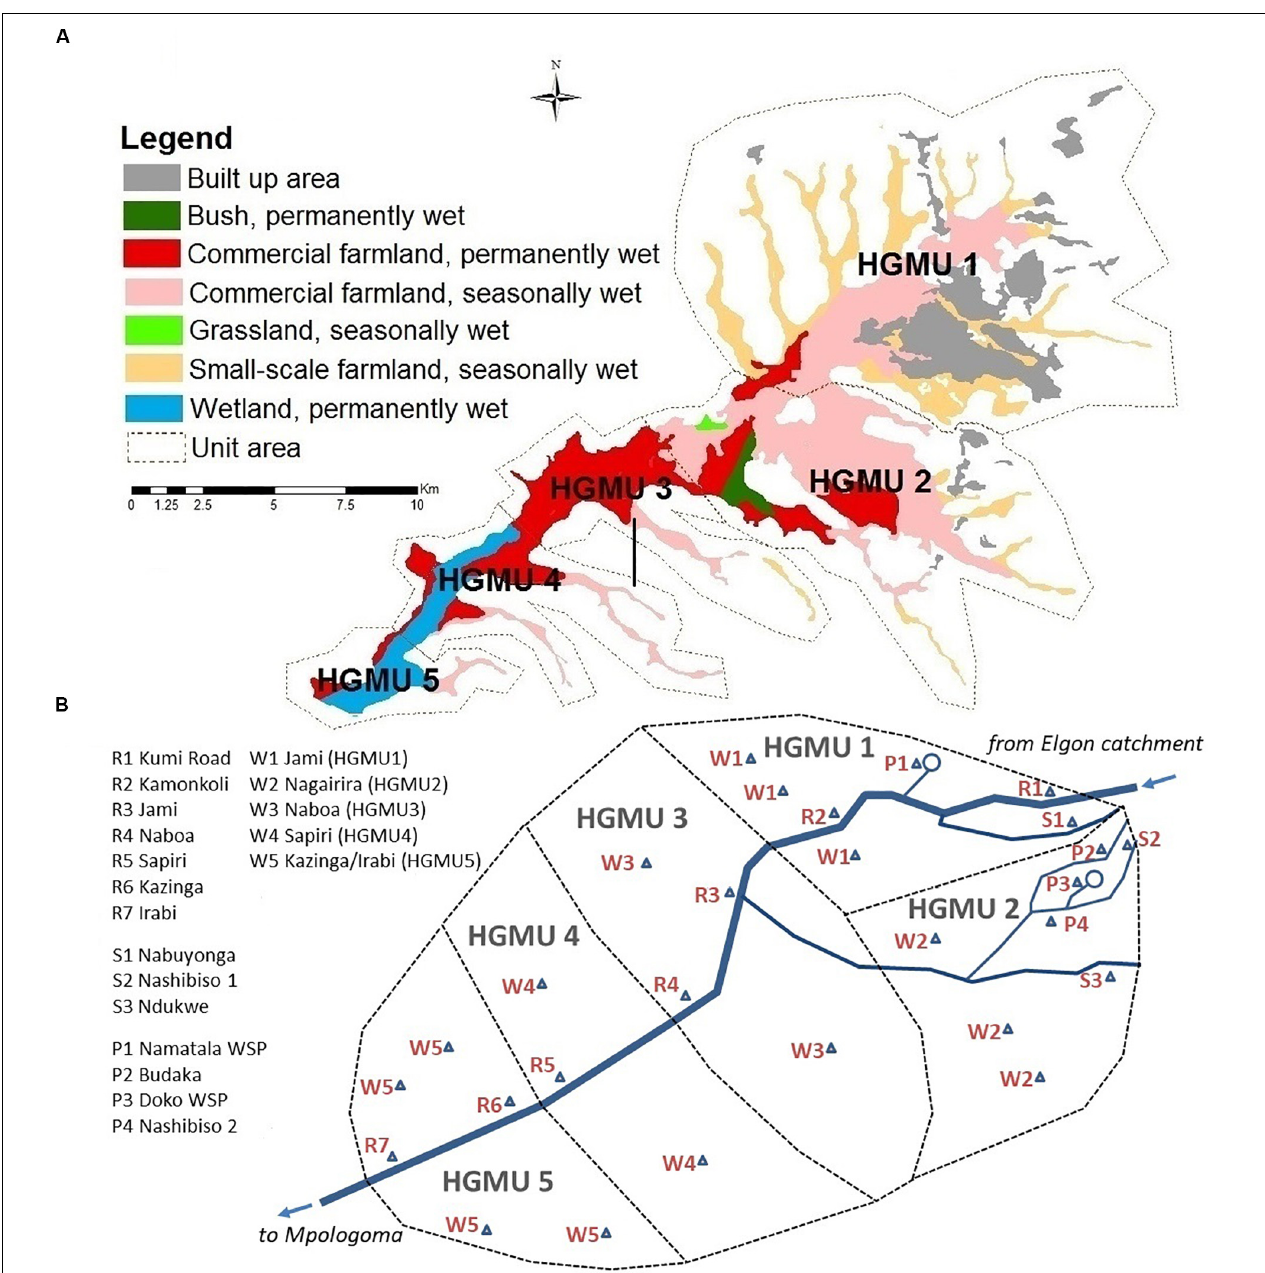
FIGURE 2 | (A) Layout of hydrogeomorphic units (HGMUs); and (B) schematic map of sampling points in Namatala Wetland, Uganda. Inflow and outflow points for calculation of net yields were: HGMU 1: P1, R1, and S1 (in) and R2 (out); HGMU 3: R3 (in) and R4 (out); HGMU4: R4 (in) and R5 (out); and HGMU5: R5 (in) and R7 (out) (see legend for codes; R, river; S, rural streams; P, polluted streams; W, wetland). For HGMU 2, no net yield calculation was done because no outflow location was available. WSP, wastewater stabilization pond. For further explanation, see text. Data source for (A) Mapping and Inventory Centre, National Forestry Authority Uganda, 2005. Map produced by